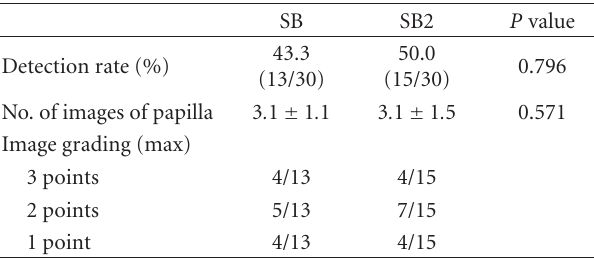
Table 2: Results of wireless capsule endoscopy comparing SB and SB2 capsule.